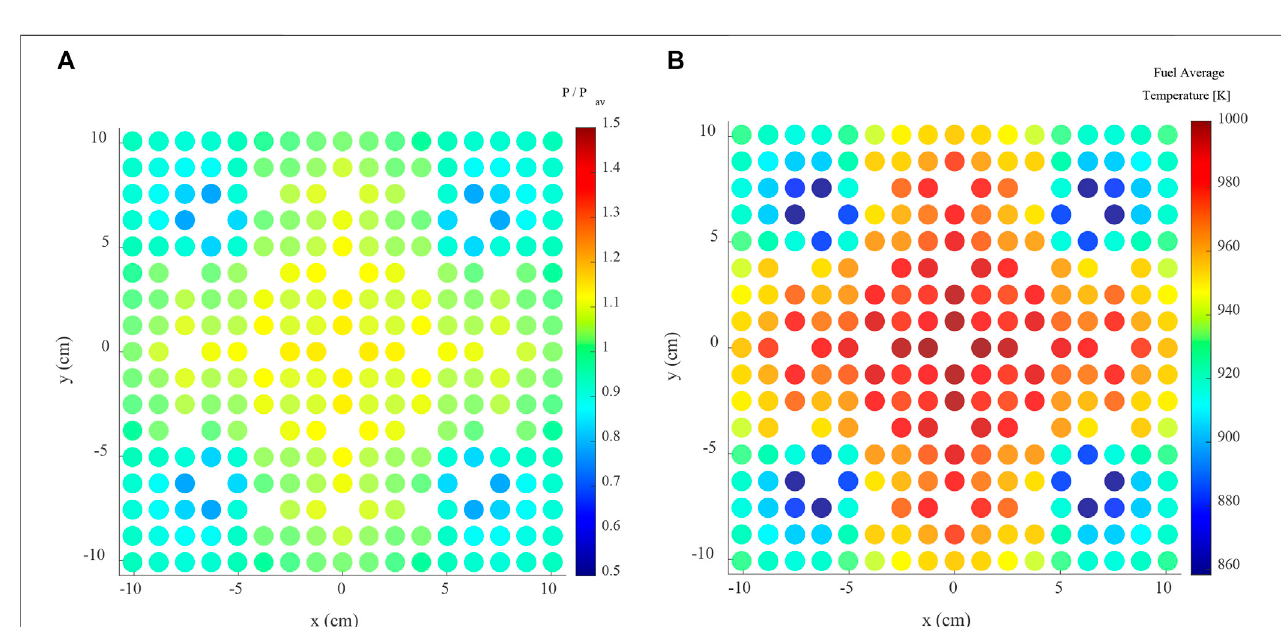
FIGURE 4 | Initial steady-state pin-power distribution (A) and fuel temperature distribution (B) .